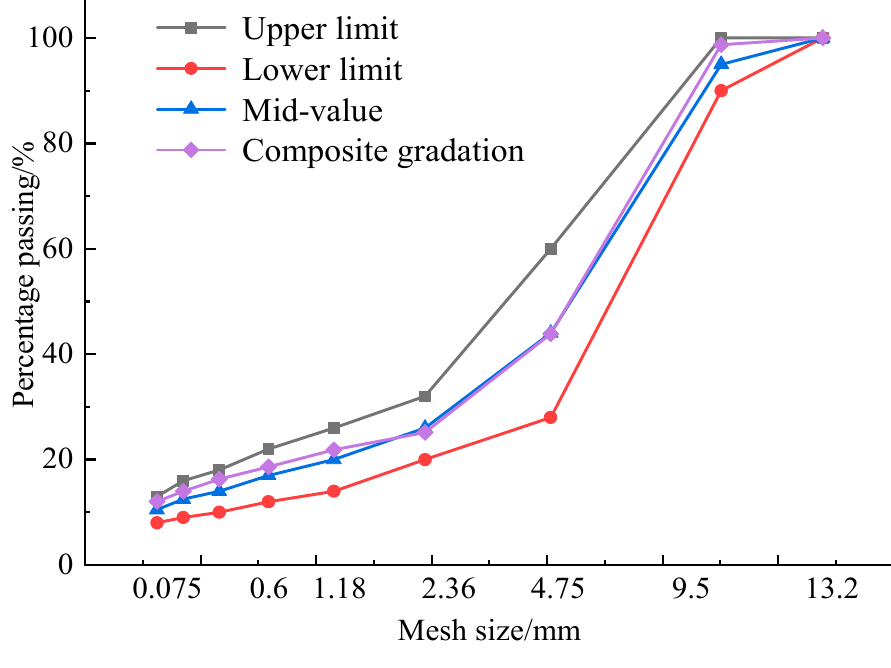
Figure 1. Designed gradation curve.